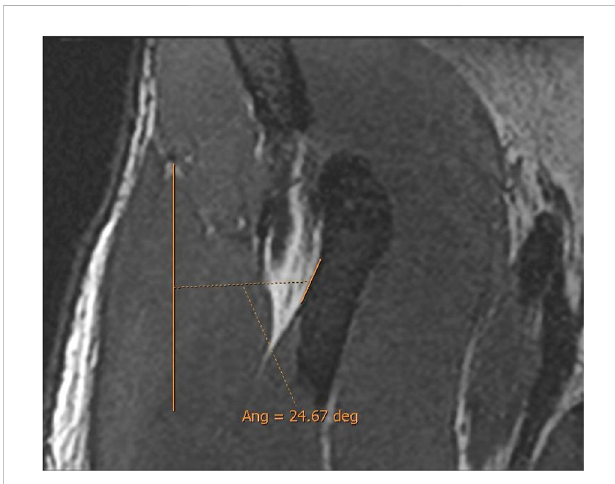
FIGURE 5 Oblique coronal 3D proton density image. Measurement of the direct tendon slope (direct tendon lateral margin/craniocaudal axis).